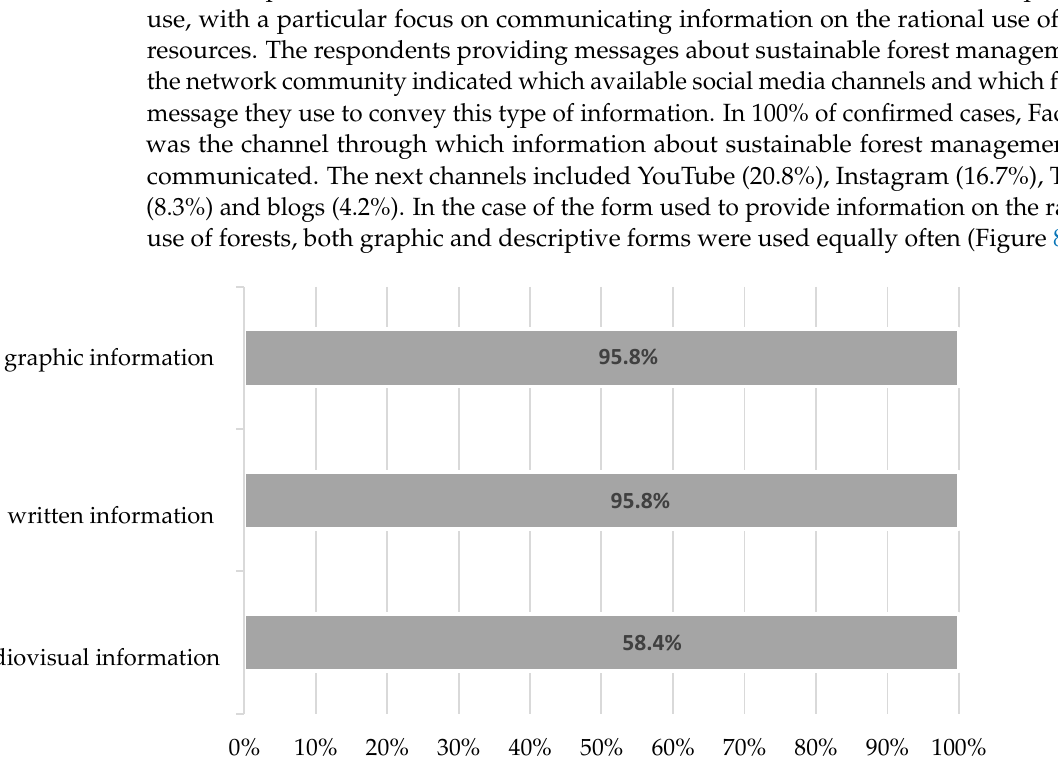
Figure 8. Form of the message used to provide information on the rational use of forest resources. Source: authors’ own elaboration.